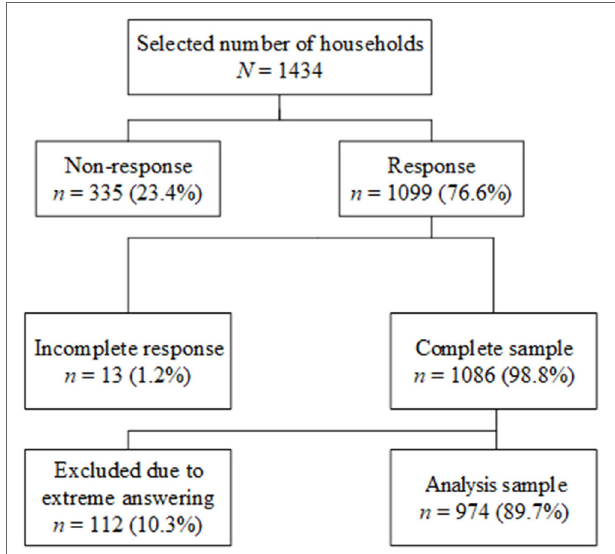
FigUre 1 | Overview of sample composition general population.